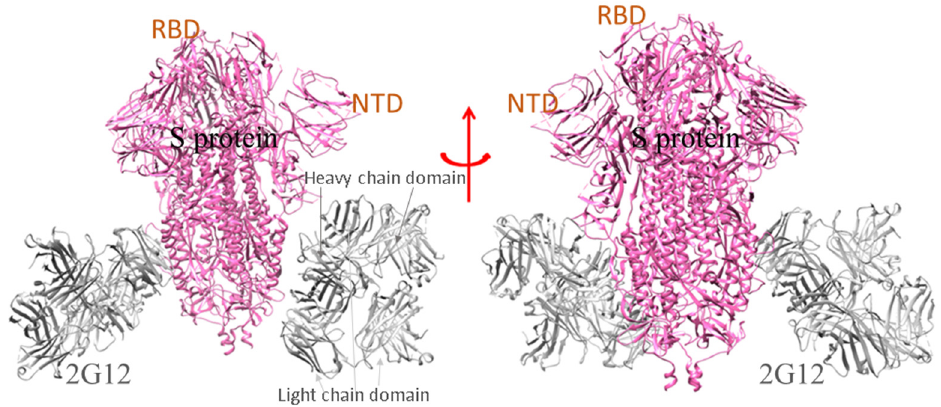
Figure 2. The ribbon model shows the SARS ‐ CoV ‐ 2 2P S ‐ protein ectodomain bound to two copies of domain ‐ swapped antibody 2G12 [PDB id: 7L06]. The heavy chain domain of Ab(2G12) interacts with the NTD part of the S ‐ protein.